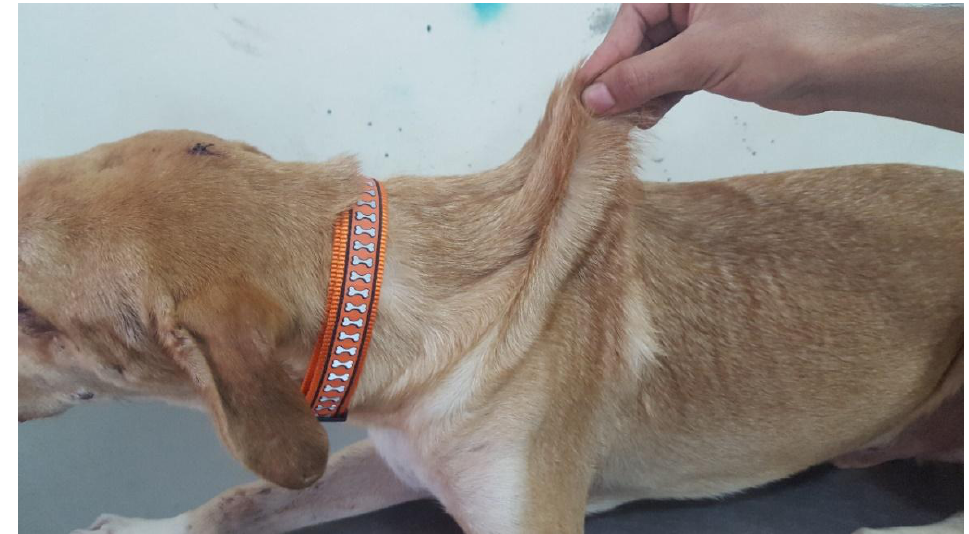
Figure 5. Case 2, Skin hyperextensibility over the dorsum.